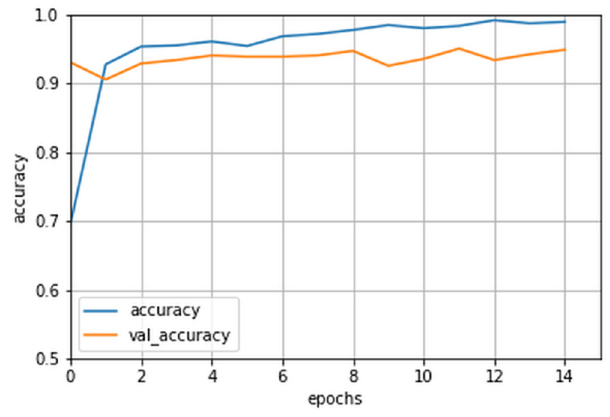
Figure 7. Training and validation set accuracy over epochs (Exp3).